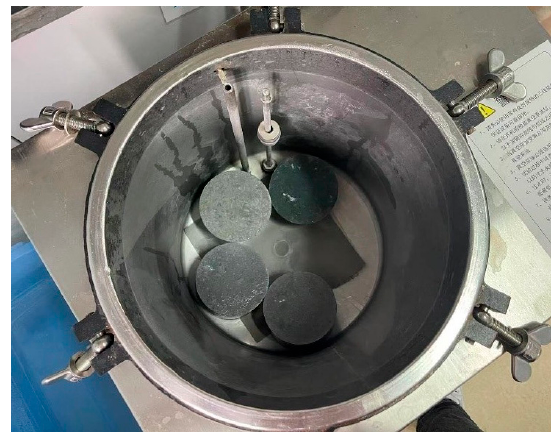
Figure 2. Specimens after vacuum saturation.